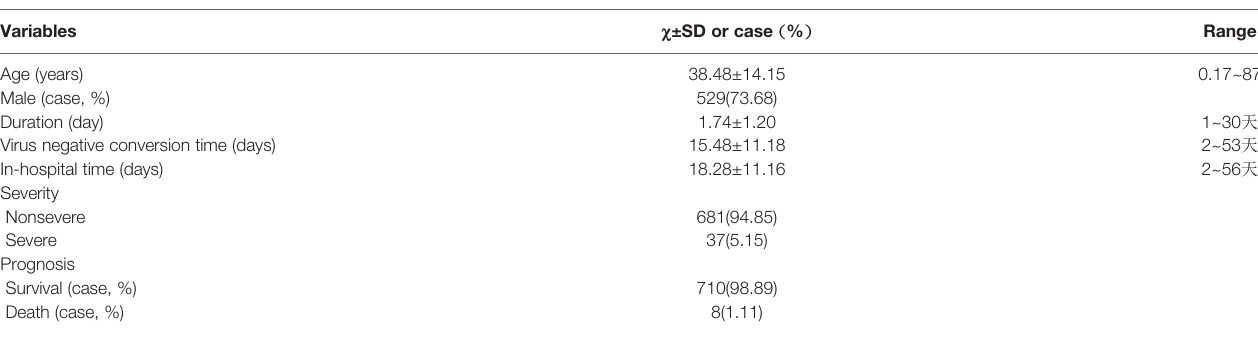
TABLE 1 | Baseline information ( n